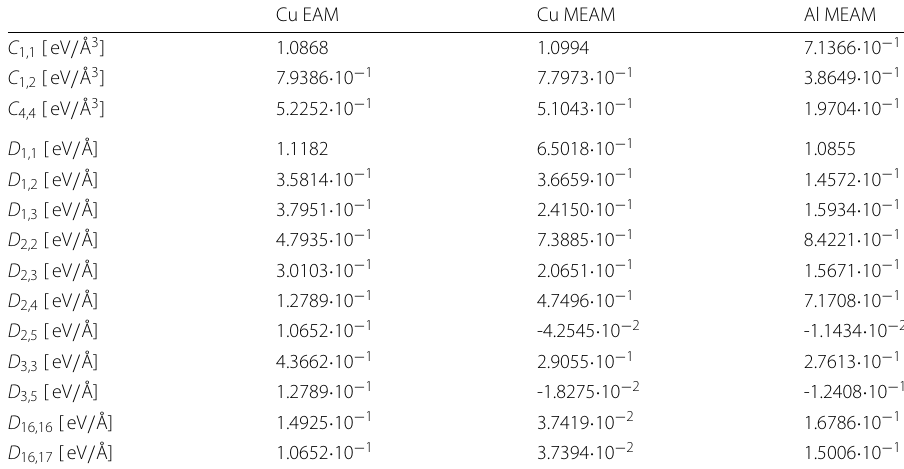
Table 1 Elastic and gradient-elastic constants obtained from the interatomic potentials Lee (2014) and Mendelev (2014) Cu EAM Cu